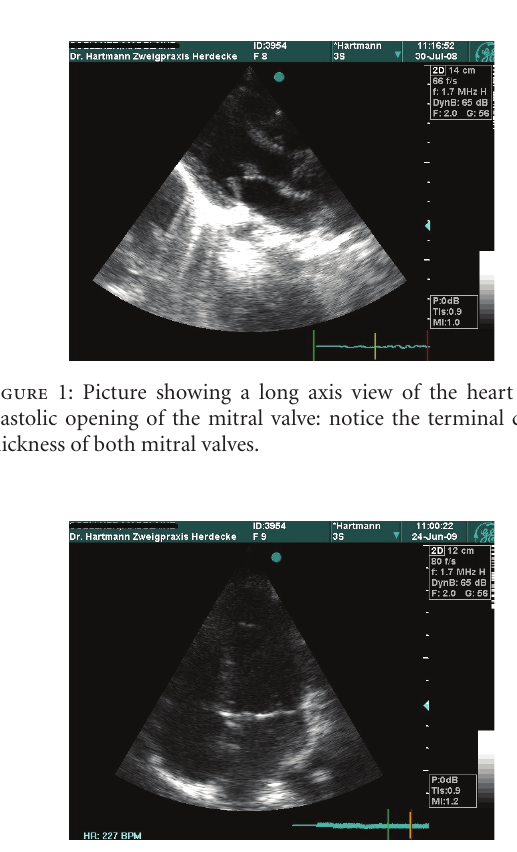
Figure 2: Four chamber view. 1 year later: mitral valve without